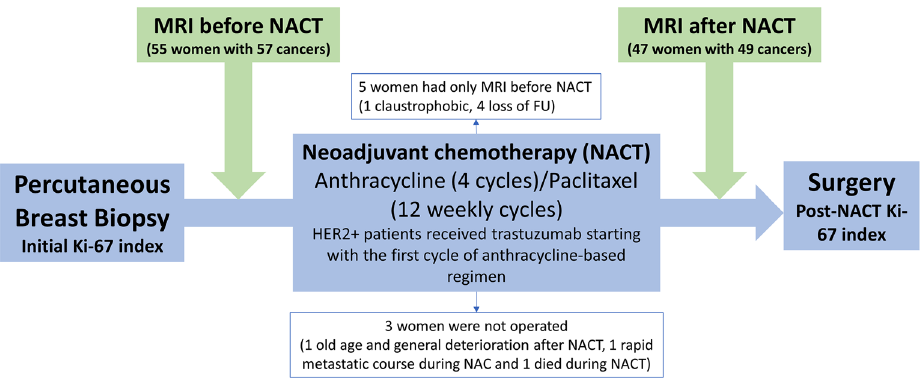
Figure 1. Illustration of the study